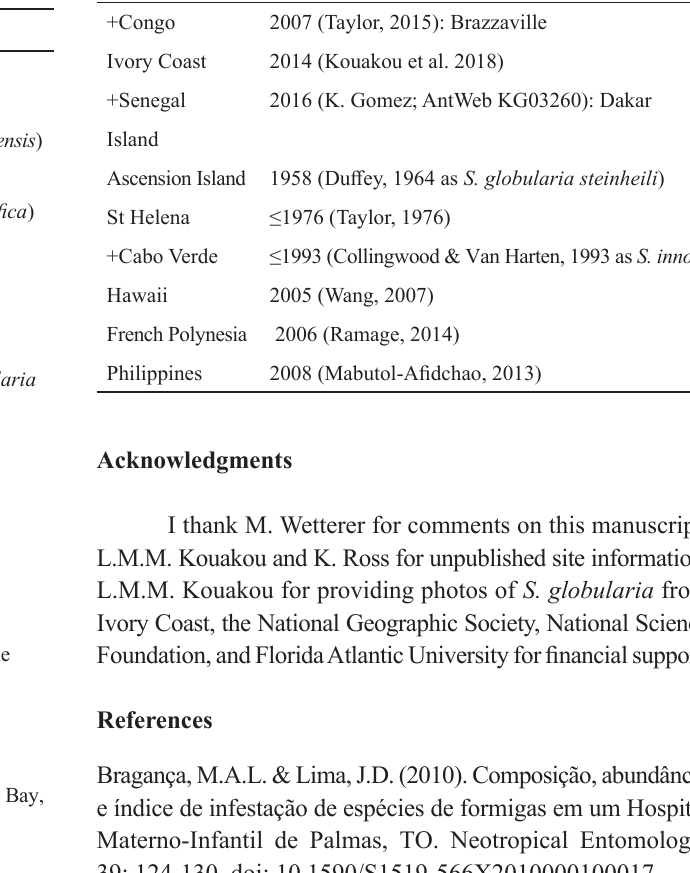
Table 2 . Earliest known records for Solenopsis globularia on islands of the West Indies and the Galapagos. + = no previously published records. MCZ = Museum of Comparative Zoology. USNM = US National Museum of Natural History.